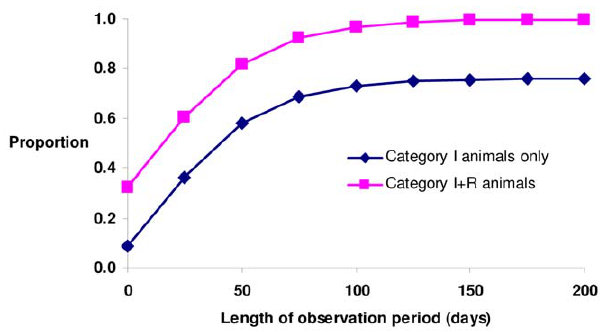
Figure 4. An example of the proportion of individuals recorded as infectious/diseased relative to those ever infectious/diseased during an SIR epidemic, as a function of recording period. Two cases are shown, with only I individuals observable or with both I and R observable. In this example, recording is triggered when prevalence reaches 5%. Parameters in this model are: b =0.00015, c =0.1 and